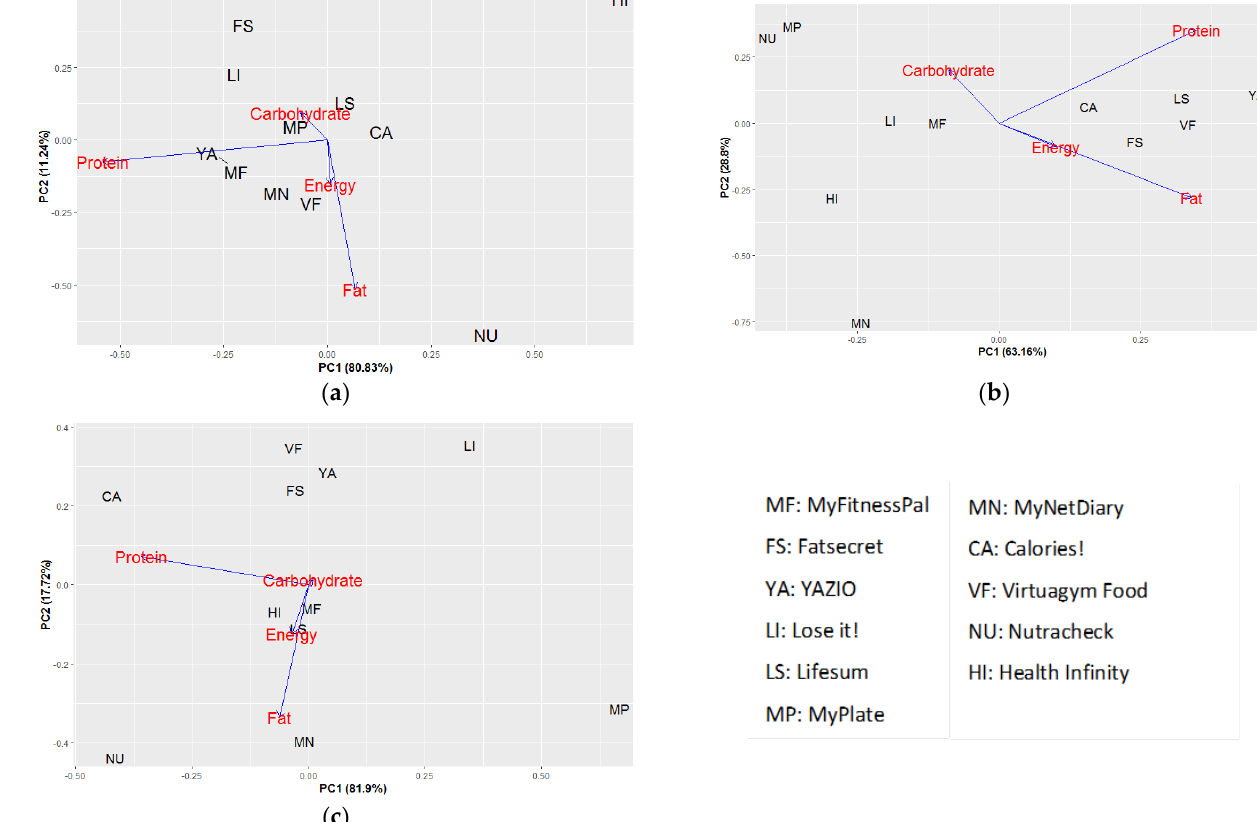
Figure 2. Principal Component Analysis (PCA) showing the variation strength and trend of macronutrient difference compared with the reference contents from different apps in ( a ) Boerenkool stamppot, ( b ) Pizza with salami, tomato, and mushrooms, ( c ) Hachee.